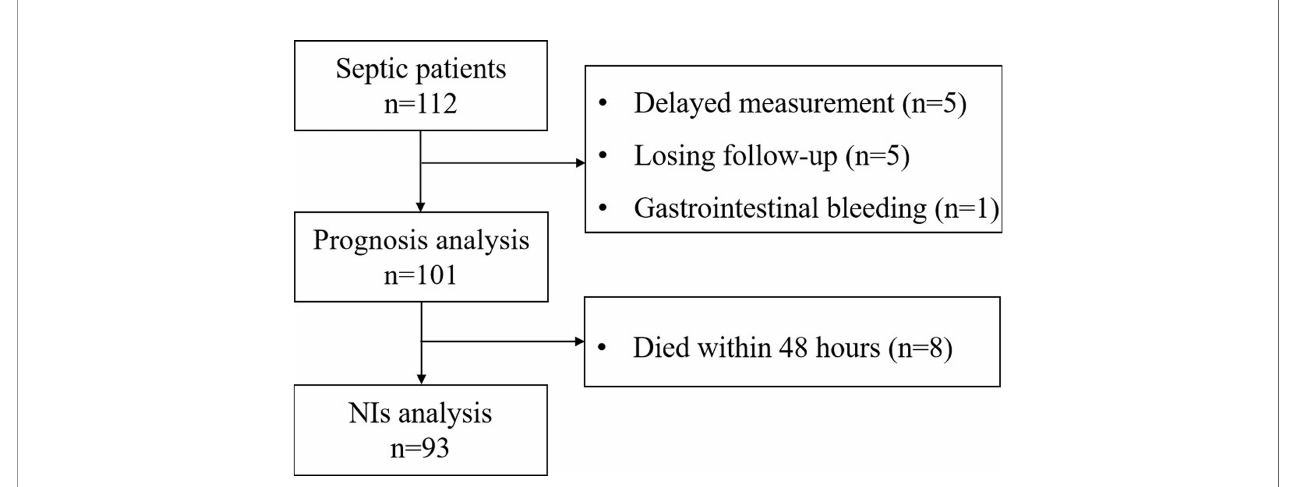
FIGURE 1 | Flowchart of the included patients and reasons for patient